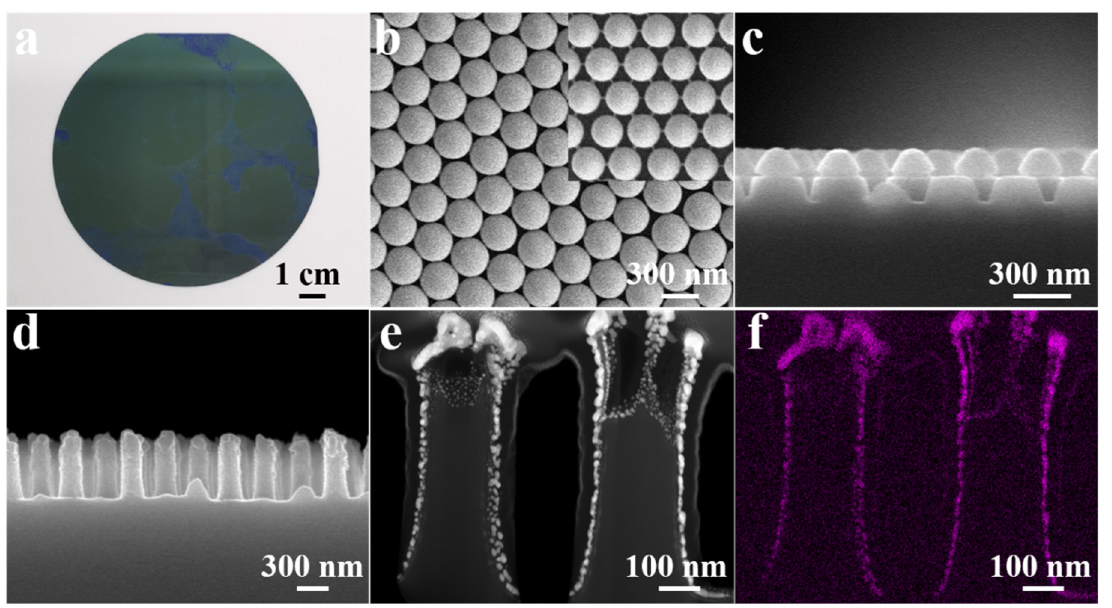
Figure 3. ( a ) The digital image of PS spheres’ monolayer in Si wafer with a diameter of about 10 cm. The SEM images of ( b ) hexagonally packed PS spheres monolayer; the insert is the etched PS spheres’ monolayer, ( c , d ) side − view of the SiO 2 nanorod arrays and the SiNRs. The TEM image of ( e ) the SiNRs decorated with Au nanoparticles and ( f ) mapping of Au element.